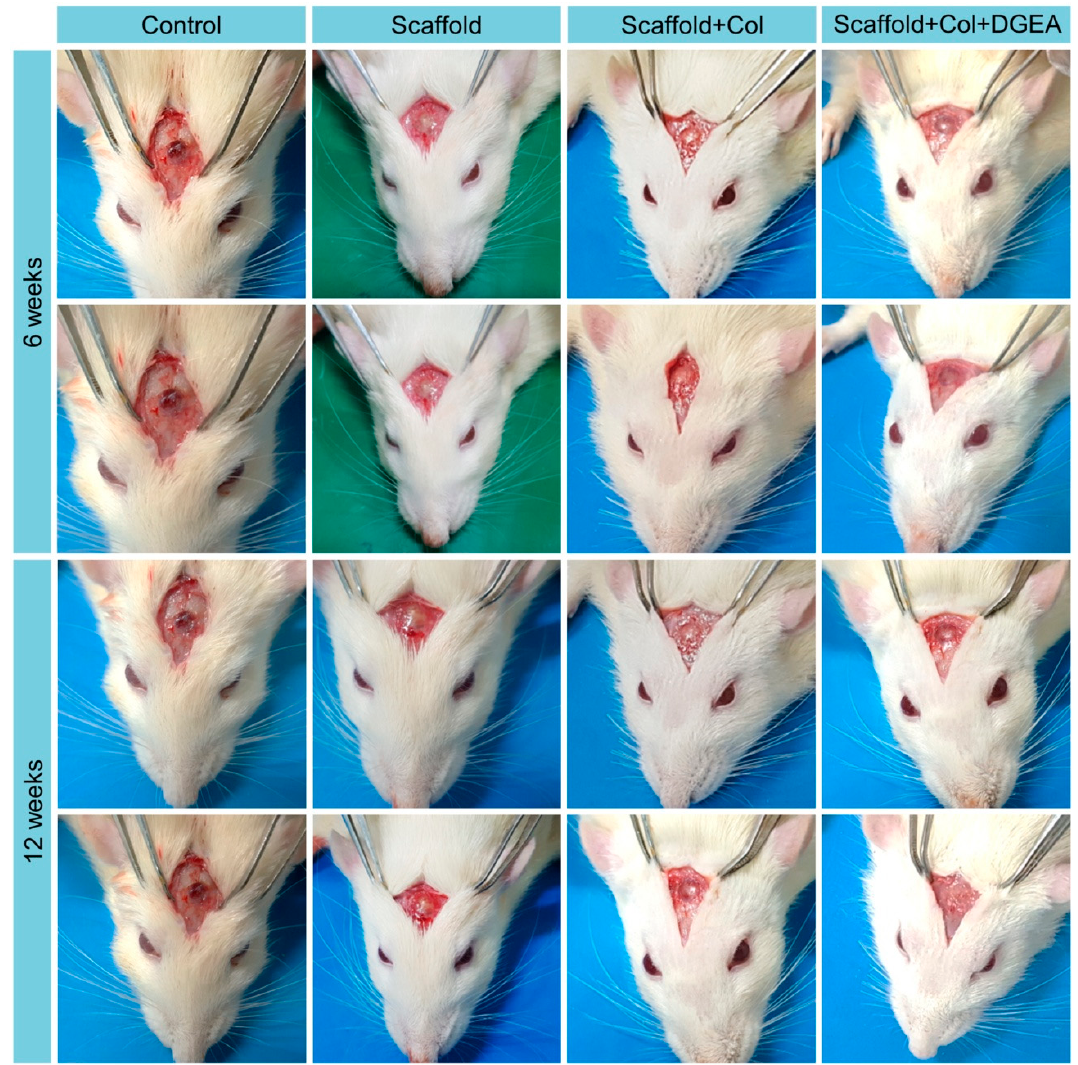
Figure 2. Gross morphologies of skull defect sites at 6 and 12 weeks post-implantation.